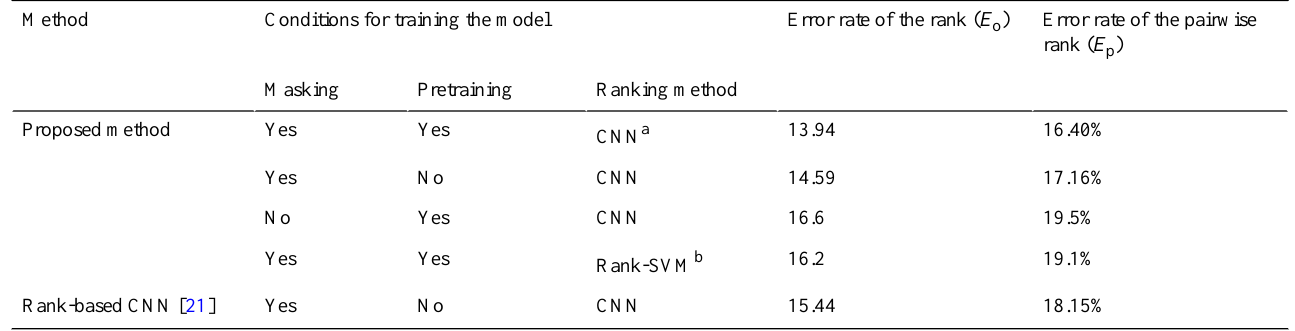
Table 1. Evaluation of the error rate of healthiness between